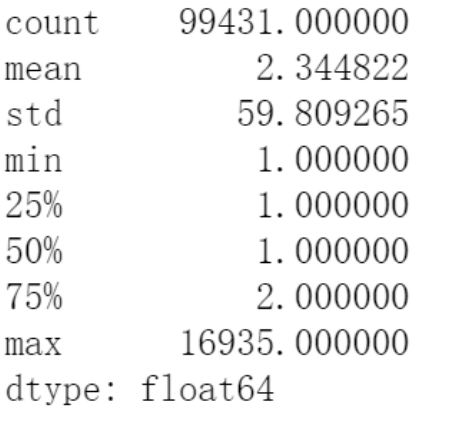
Figure 13. Sentence Repeat Statistics.